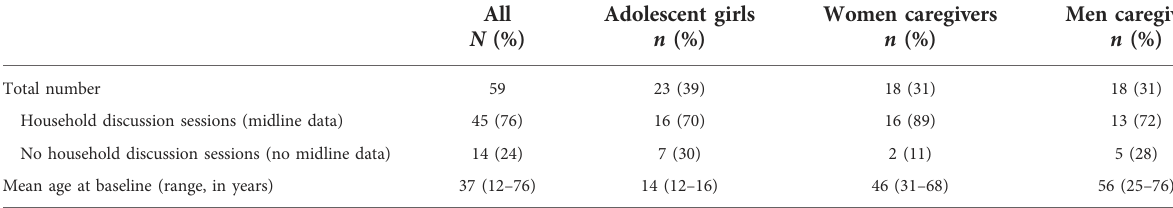
TABLE 1 Characteristics of qualitative study participants.